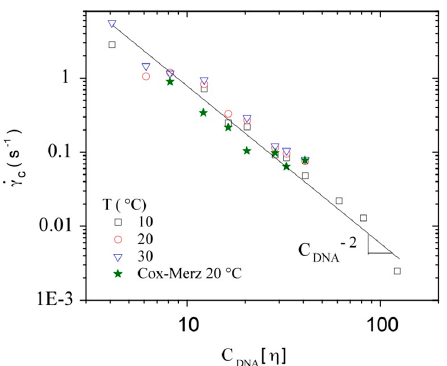
Figure 12. Dependence of the critical shear rate, of the onset of the Non-Newtonian viscosity, with C DNA [ η ] as a function of polymer concentration and for the temperatures 10, 20, and 30 °C. The values obtained by Cox-Merz analysis, discussed later, are also represented.